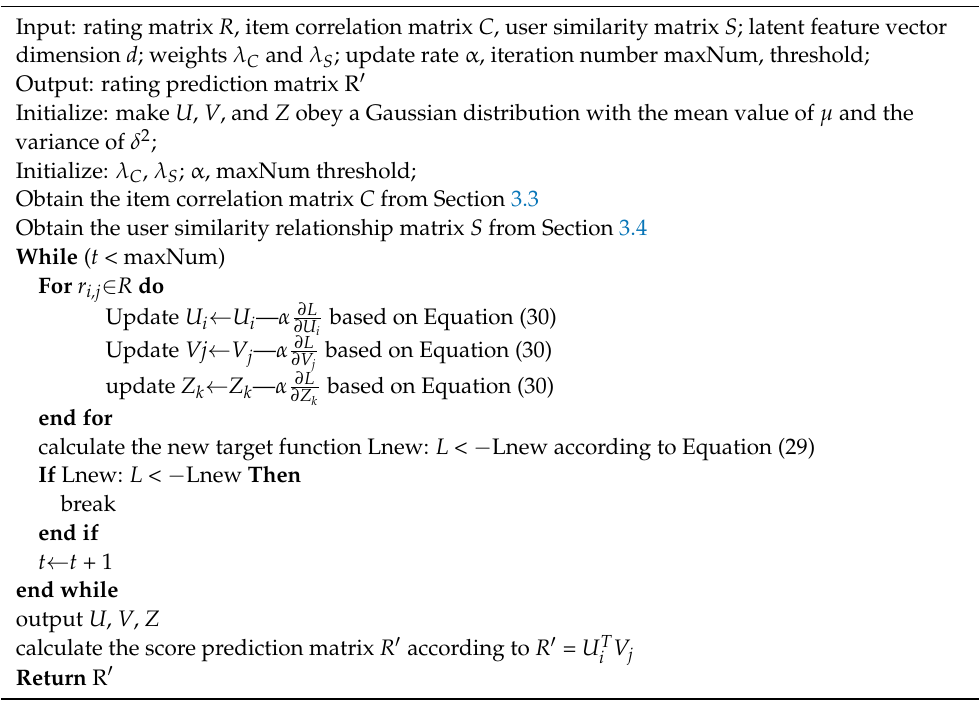
Algorithm 1. PMF recommendation model integrating the relevance of user’s rated